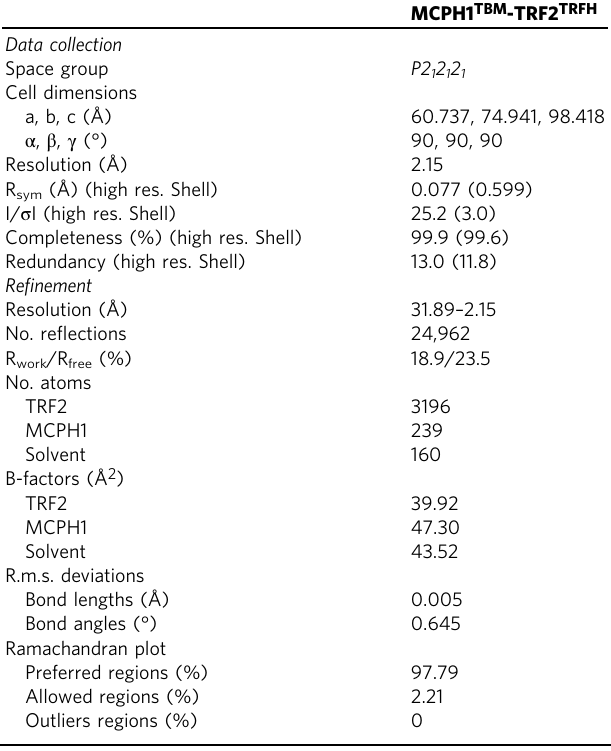
Table 1 Data collection and re fi nement statistics.